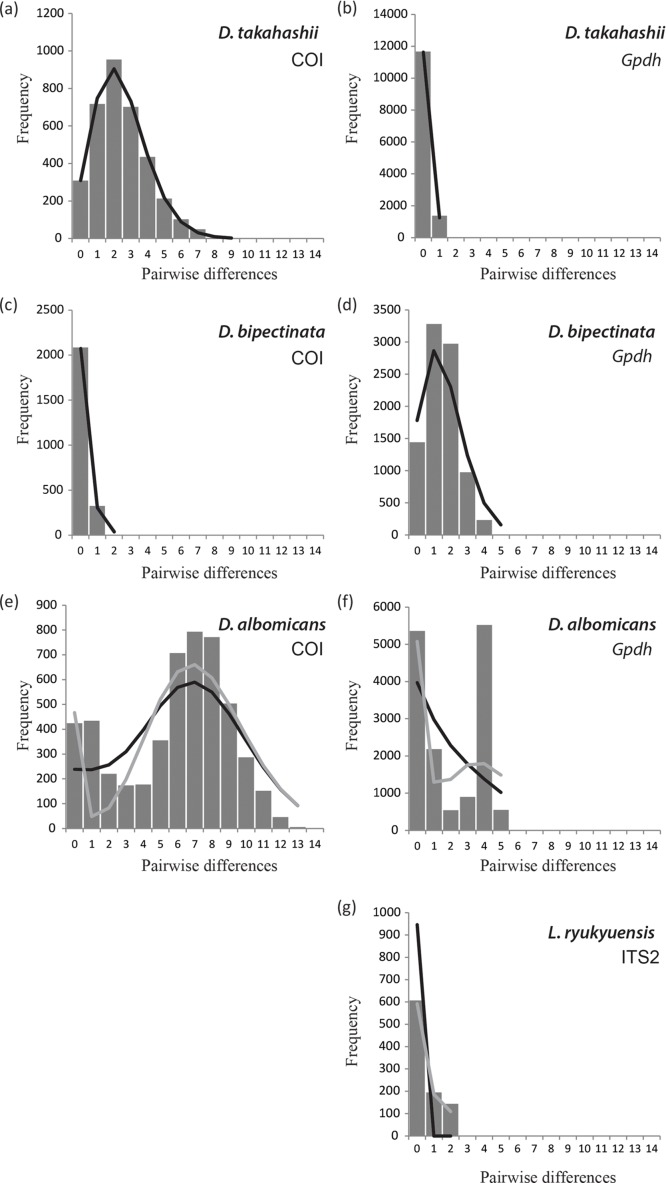
Pairwise mismatch distribution calculated for mitochondrial and nuclear markers of the four study species.Solid histograms represent observed differences, black line the expected distribution compatible with a sudden-expansion model, and gray line the distribution compatible with the spatial expansion model. Where both models overlap, only the black line is shown.